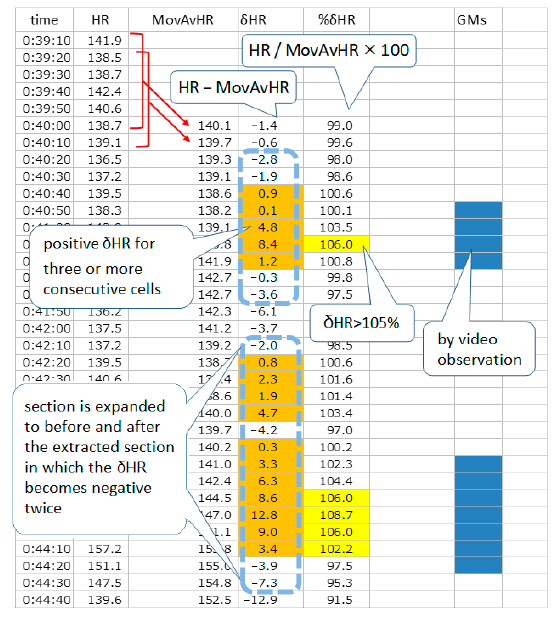
Figure 1. Example spreadsheet for AES